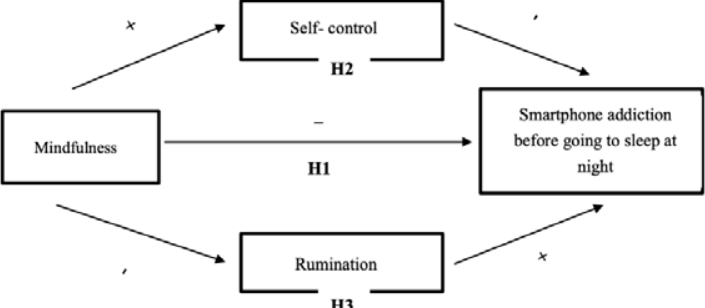
Figure1. Themediationmodelfrommindfulnesstosmartphoneaddictionviaself-controlandrumination. Figure 1. The mediation model from mindfulness to smartphone addiction via self-control and rumination.